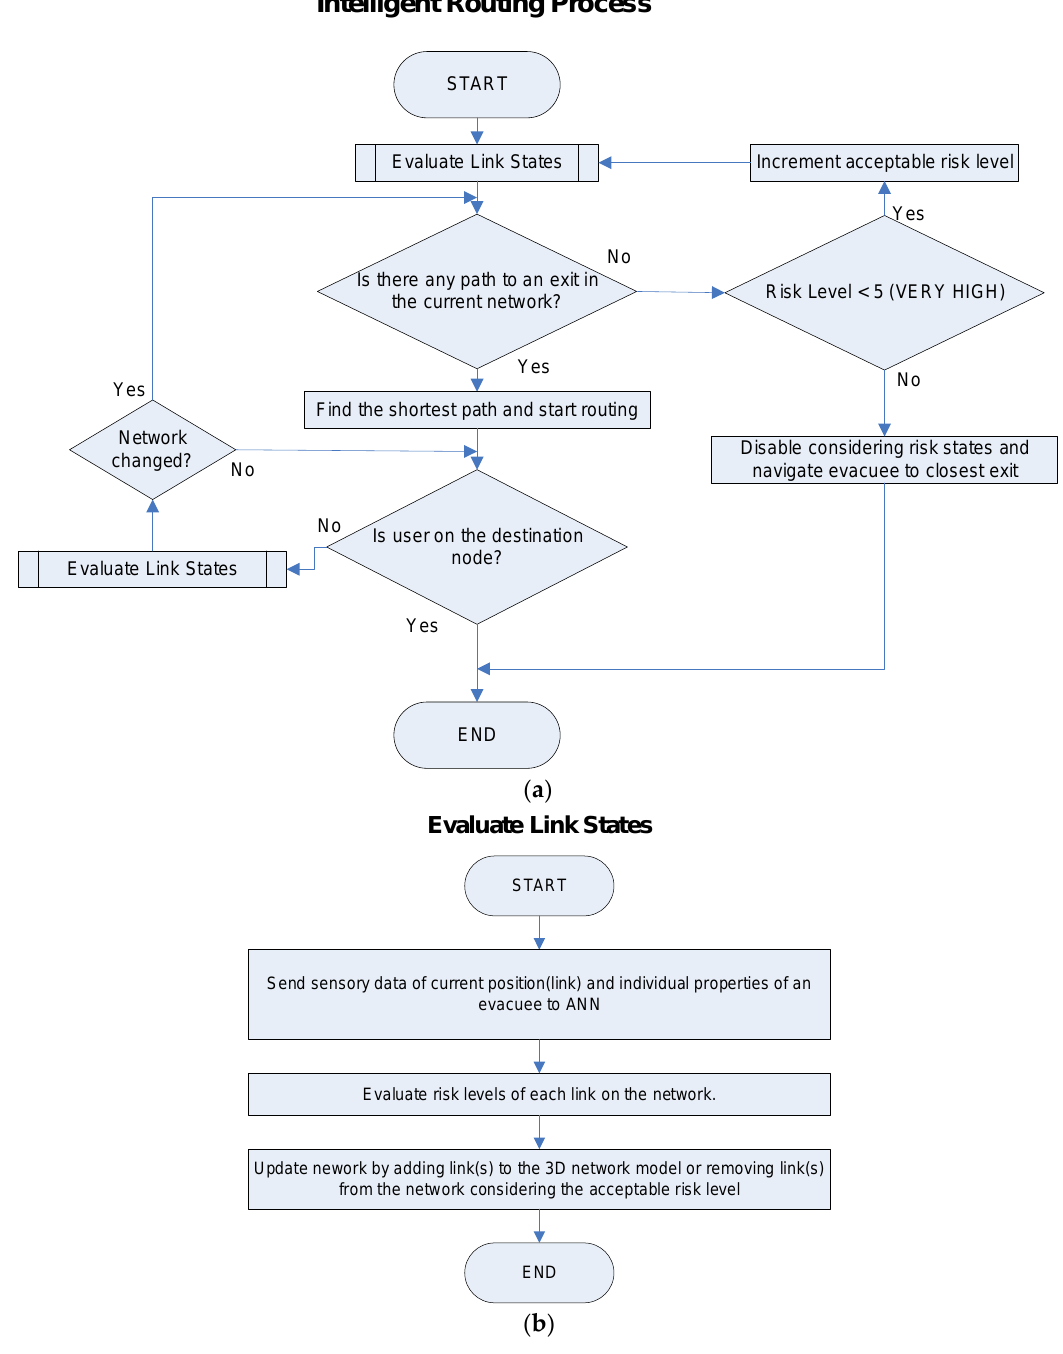
Figure 7. ( a ) ANN based routing; ( b ) evaluating links states.